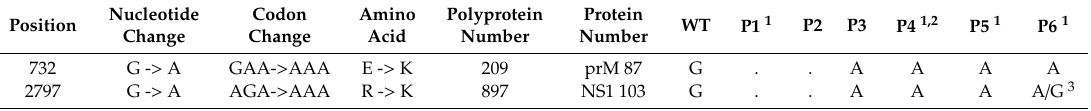
Table 1. HeLa-passaged ZIKV PA259249 incurred two amino acid